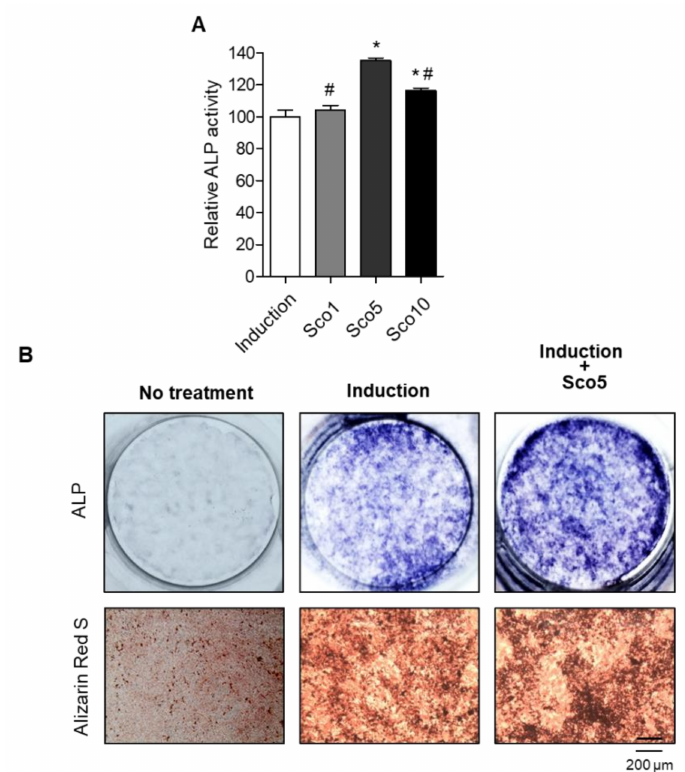
Figure 2. Scopolin treatment increased cellular di ff erentiation and mineralized nodule formation in the MC3T3-E1 osteoblastic cell line. ( A ) The cells were cultured in three di ff erent concentrations of scopolin (1, 5, and 10 µ M) for 3 days, and alkaline phosphatase (ALP) activity was measured. Measurements of ALP activity were repeated three times. ( B ) ALP and alizarin red S staining of cells treated with 5 µ M scopolin. At least three replicate images were captured for each stained sample. Sco 1: scopoline 1 µ M, Sco 5: scopoline 5 µ M, Sco 10: scopoline 10 µ M, Induction: Non-scopolin-treated cells. * p < 0.05 vs. Induction, # p < 0.05 vs. Sco5 (Tukey’s honest significant di ff erence post hoc test, analysis of